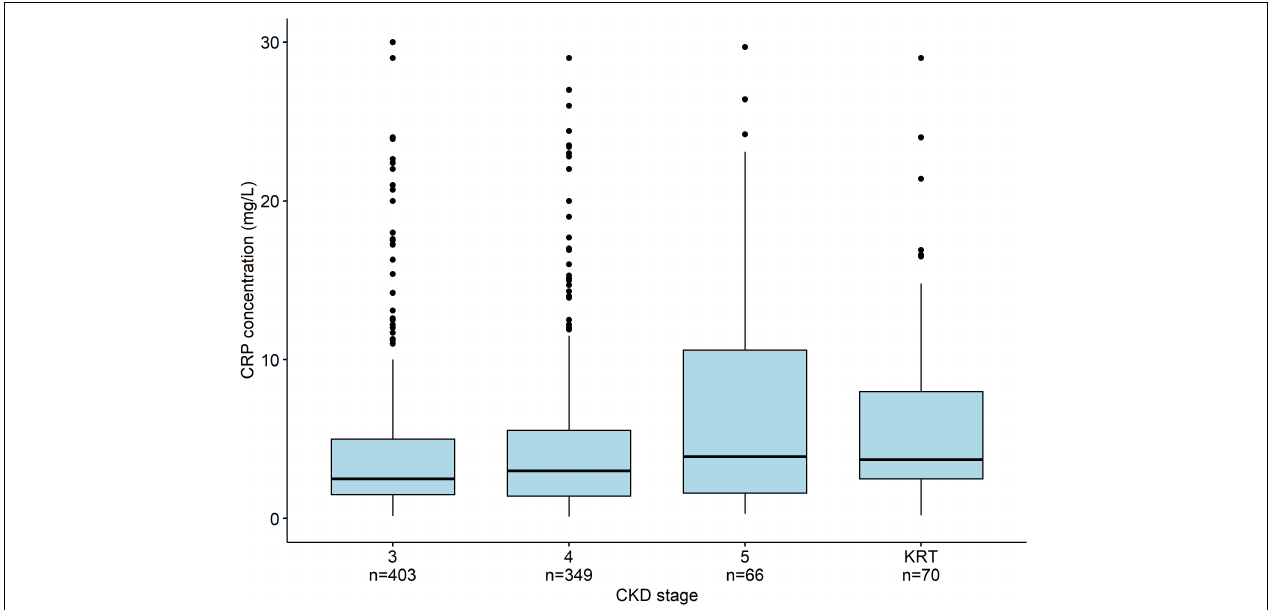
FIGURE 2 | The median (IQR) serum CRP concentration as a function of the CKD stage. The CRP levels rise significantly ( p < 0.001) with the CKD stage. To facilitate visual comparisons, outliers (including some > 300 mg/L) are not displayed. The whiskers correspond to 1.5 times the